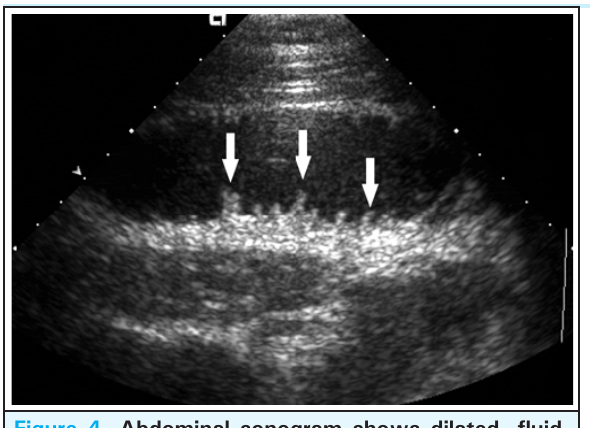
Figure 4. Abdominal sonogram shows dilated, fluid- filled loop of small bowel with prominent valvulae conniventes (white arrows).